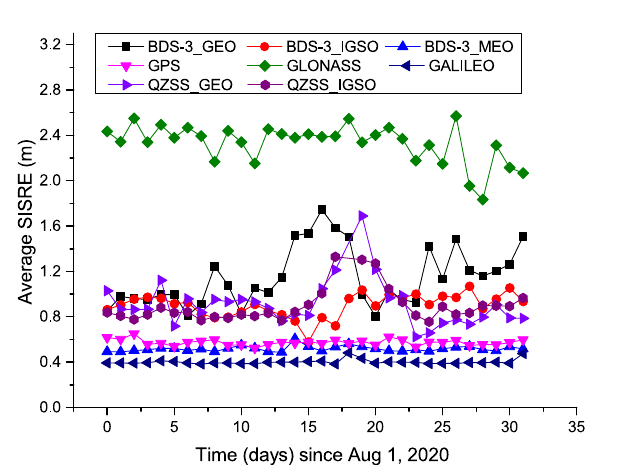
Figure 6. SISREs of major systems from Aug 1, 2020 to Sep 1, 2020. For comparison, BDS-3 satellites were grouped into the three categories of GEO, IGSO, and MEO. QZSS satellites are also made a similar classification.